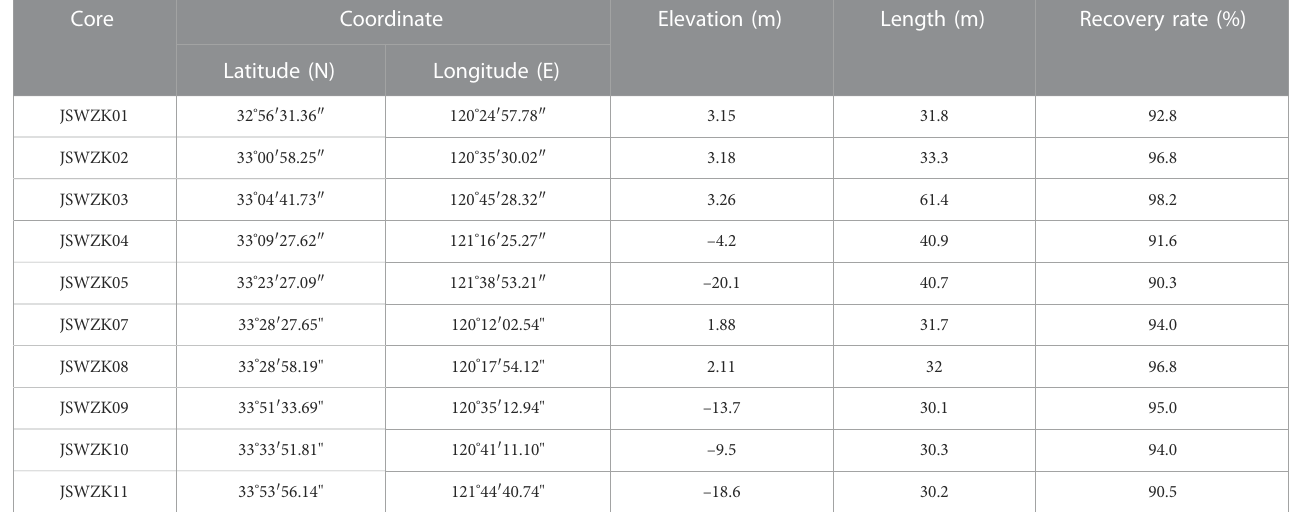
TABLE 1 General information about the 10 cores investigated in this